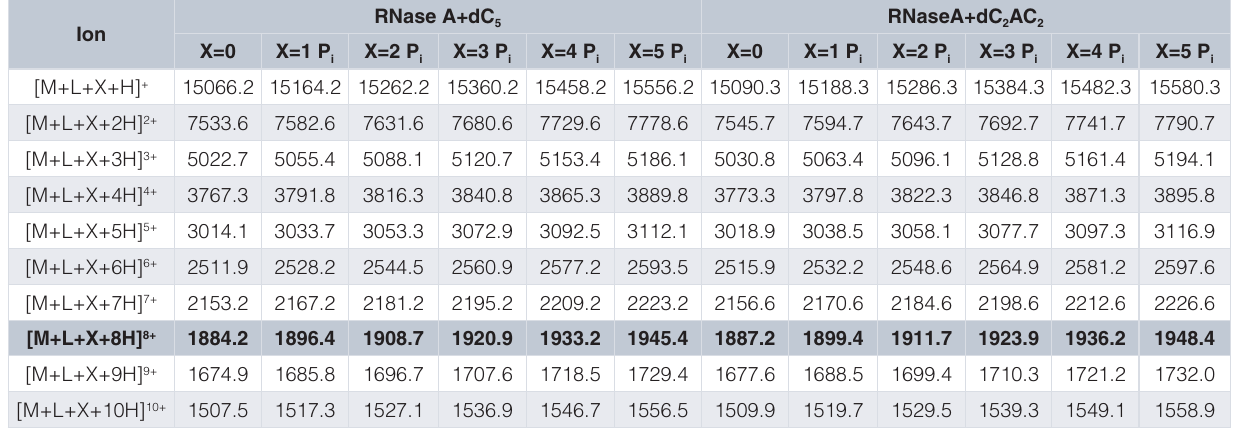
adducts (X) 2 . The +8 charge state used in this work is i